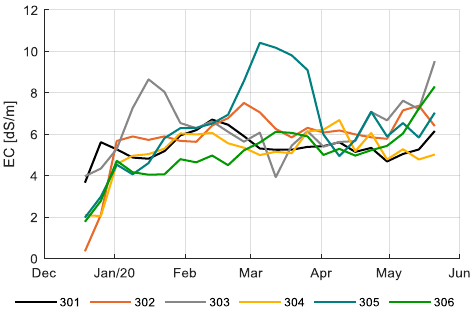
Figure 11. EC (dS/m) in drain water in the greenhouse compartments (301–306).